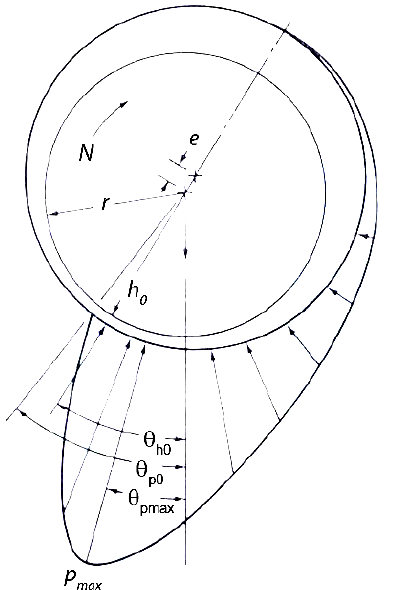
Figure 1: Sketch of a hydrodynamic journal bearing and parameters used in numerical